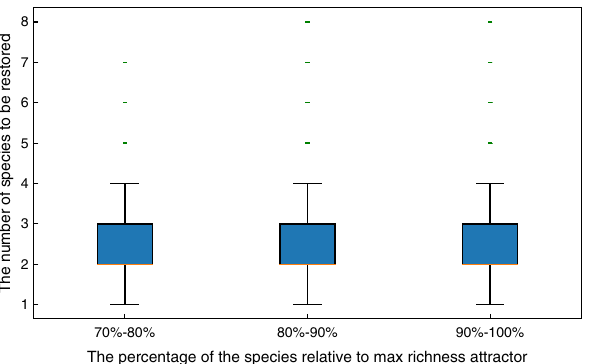
Figure 11. The number of species that need to be restored to save 70% of more of the species in the maximal richness community. In this analysis 6000 networks with 50–70 nodes were the subject. For each networks all the attractors that have 70% or more of the species in the maximal richness attractor are identified and set to be the target attractors. The control set of these attractors are then classified into three groups based on the percentage as illustrated in the figure. From left to right, the box and whiskers represent the size of the control set of attractors that have 70–80%, 80–90%, and 90–100% of the species in the maximal richness attractor